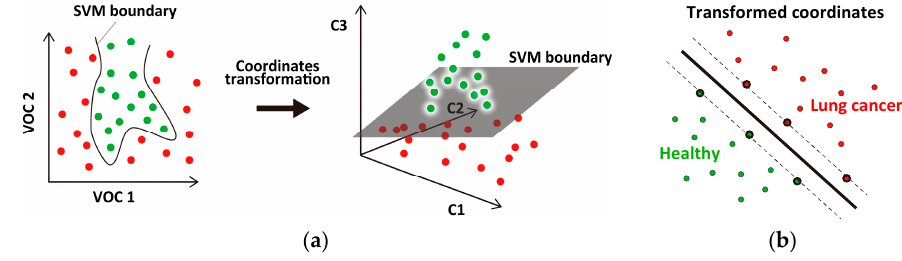
Figure 4. Schematic illustrating nonlinear support vector machine (SVM). ( a ) The two-class data set is composed of two VOCs (VOC 1 and VOC 2; left panel), which are transformed into a different coordinate space (right panel) where the dataset can be classified by a flat boundary. ( b ) The SVM boundary (thick line) is determined using data points called support vectors (thick circles). The number of support vectors should be small to avoid overfitting the data points.